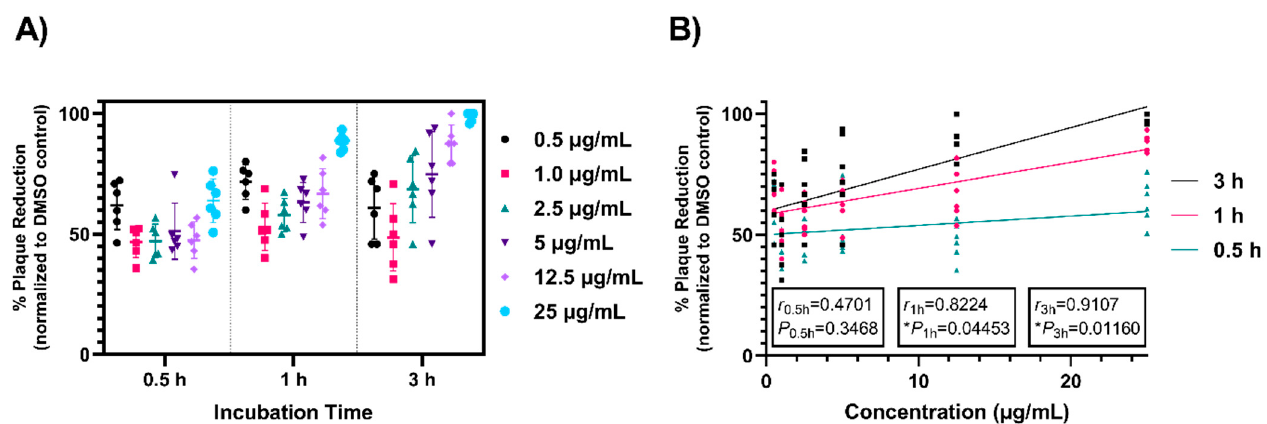
Figure 4. Complex 4 antiviral activity increases with extended incubation periods. ( A ) Complex 4 was inoculated with 150 PFU of SARS-CoV-2 at concentrations ranging from 0.5–25 µg/mL and incubated for 0.5, 1, and 3 h at 37 °C to determine dependency of time on antiviral activity. Following incubation, complex–virus mixtures were added to Vero E6 cells for a 1 h adsorption period. Infectious SARS-CoV-2 titers were quantified via plaque assay and data are reported as percent plaque reduction compared to a DMSO–virus control. Horizonal bars represent the mean and error bars represent the standard deviation. Data were analyzed in ( B ) for correlation of complex 4 concentrations with virus incubation time. r values indicating strength and direction between the two variables and p values were determined using Pearson correlation coefficients test. Data are shown from two biological experiments conducted in triplicate. * p = 0.0332, ** p = 0.0021.